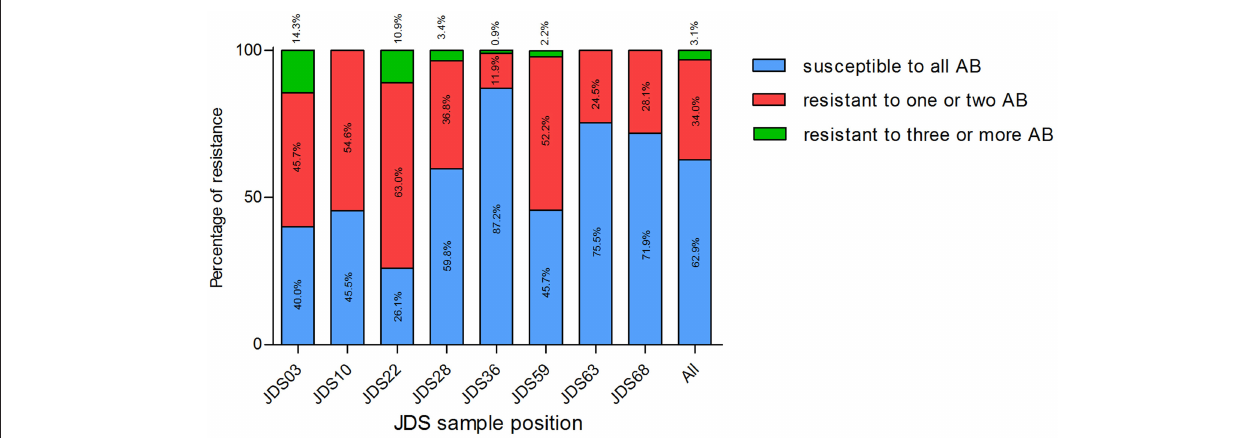
FIGURE 2 | Proportion of isolates susceptible to all tested antibiotics (blue bars), resistant to one or two tested antibiotics (red bars) and resistant to three or more tested antibiotics (green bars), at different sampling points. JDS03, JDS28, JDS63, and JDS68 are non-urban sampling sites, whereas JDS10